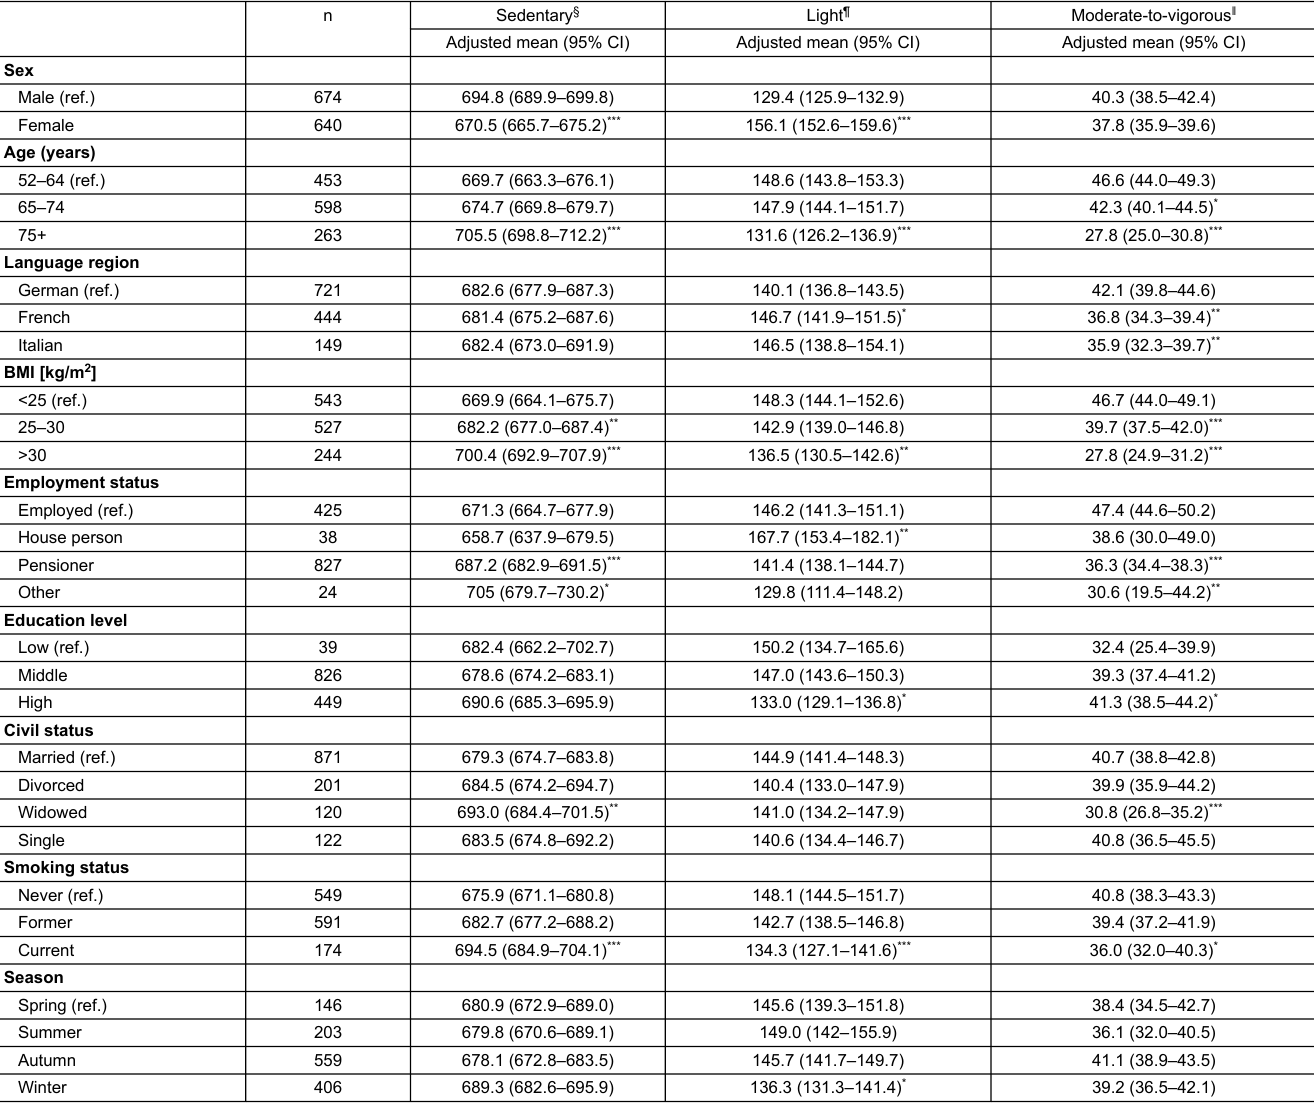
Table S3: Mean minutes per day † spent in specific levels of physical activity intensity (n = 1314), according to patients characteristics ‡ .